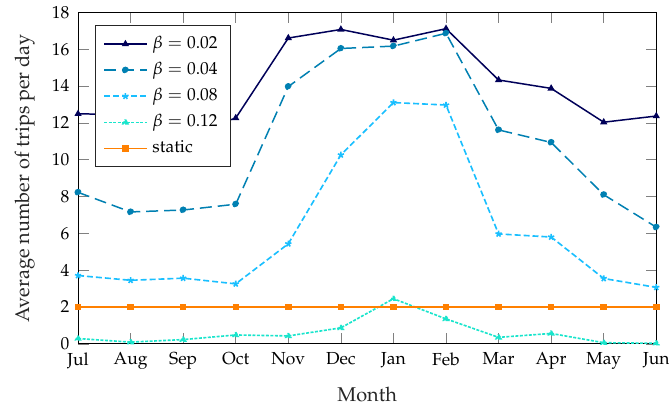
Figure 5. Average number of rebalancing trips per day, over a year.